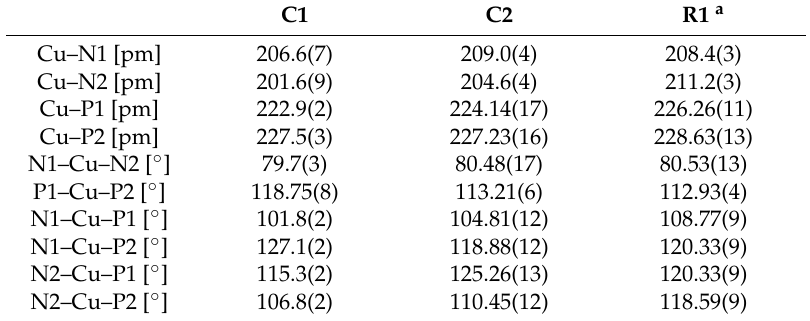
Figure 4. Solid-state structures (ORTEP representation) of ( a ) complex C1 and ( b ) complex C2 . ( c ) Packing situation of C2 in its unit cell. The thermal ellipsoids are drawn at a probability level of 50%. Hydrogen atoms, counter anions and solvent molecules are omitted for clarity. Table 1. Selected crystallographic bond lengths (pm) and angles ( ◦ ) of the complexes C1 , C2 and R1